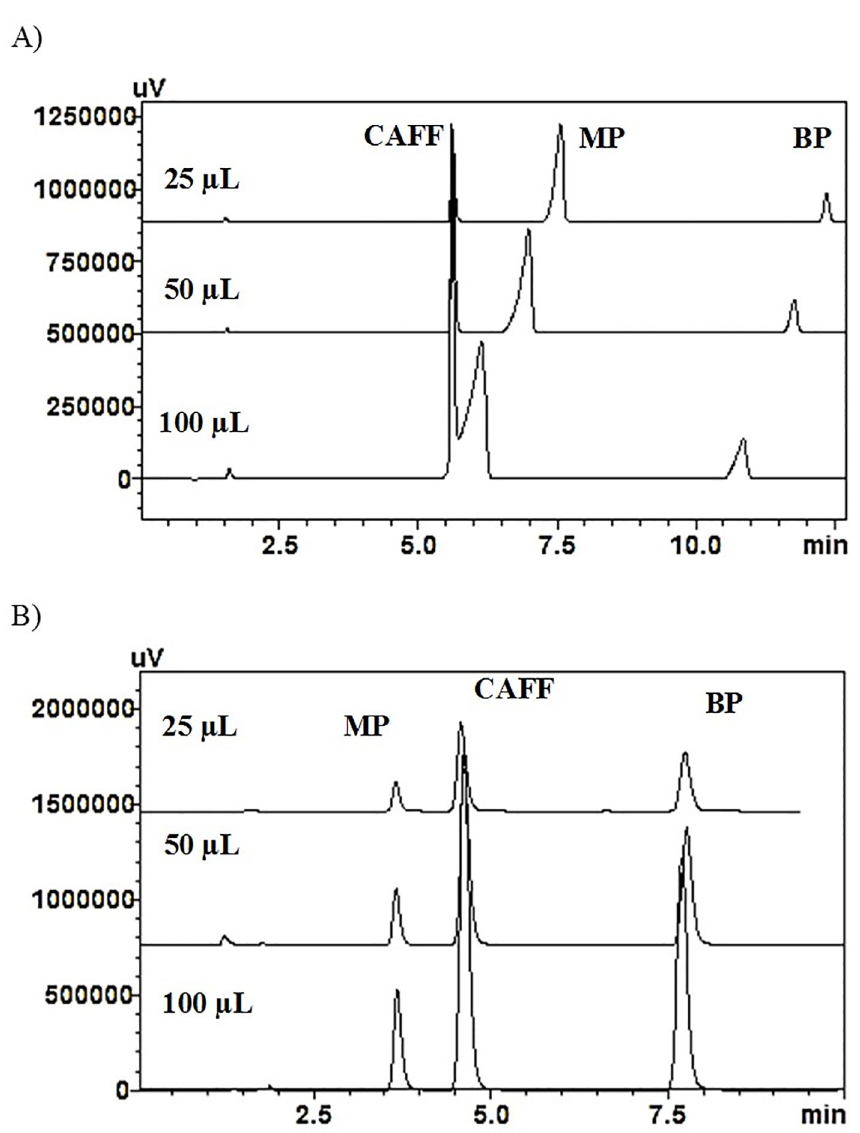
Fig 4. Elution of the analytes mixture at different injection volumes (25, 50 and 100 μ L) using A) C18 and B) CN